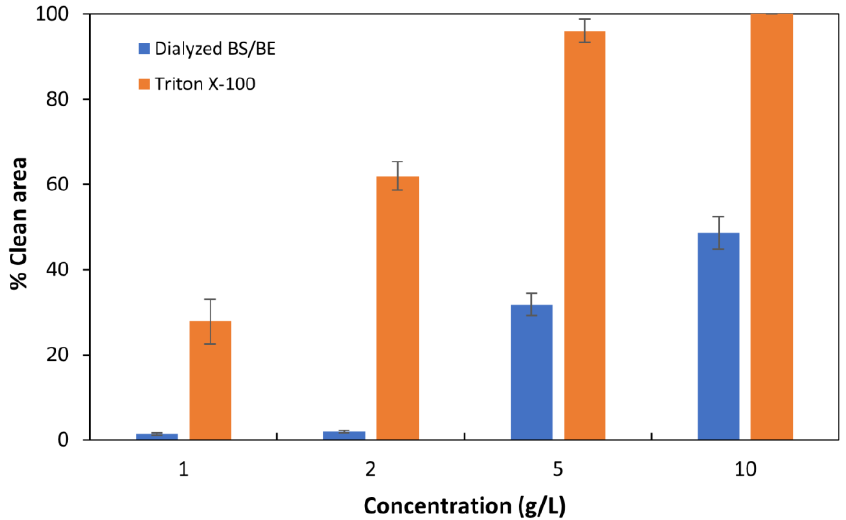
Figure 8. Results from oil dispersion test using both dialyzed BS/BE (biosurfactant/bioemulsifier) and Triton X-100. Standard deviation ( n = 3) is represented as error bars.